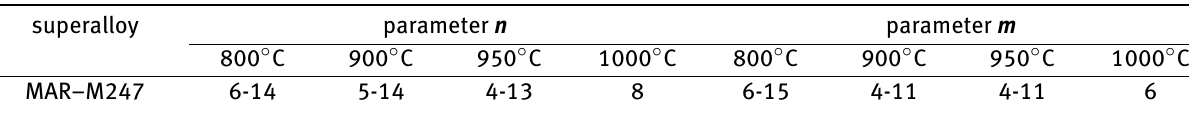
Table 2: Values of the stress exponent of the creep rate n and the stress exponent of the creep life m for superalloy MAR-247 of G variant for different testing temperatures within the used intervals of applied stress.